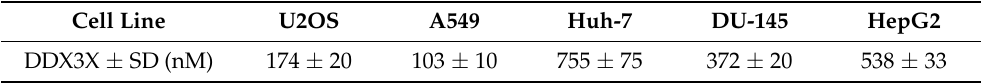
Figure 5. Cytotoxicity of selected compounds. Compounds were assayed on DU-145, PC3, HepG2, Huh-7, HN6, U251, and U87 cell lines. The concentration of the compound, which reduced the number of viable cells by 50% (CC 50 ), was determined by dose–response curve, and the mean CC 50 value for each cell line was calculated by triplicate assays (raw data from U87 and U251 cells with dose–response curves used for the calculation of CC 50 in Table S1 and Figure S2). The most active compound, BA103 , was assayed on a panel of seven additional cancer cell lines. Table 3. Concentration of DDX3X per cell [a]